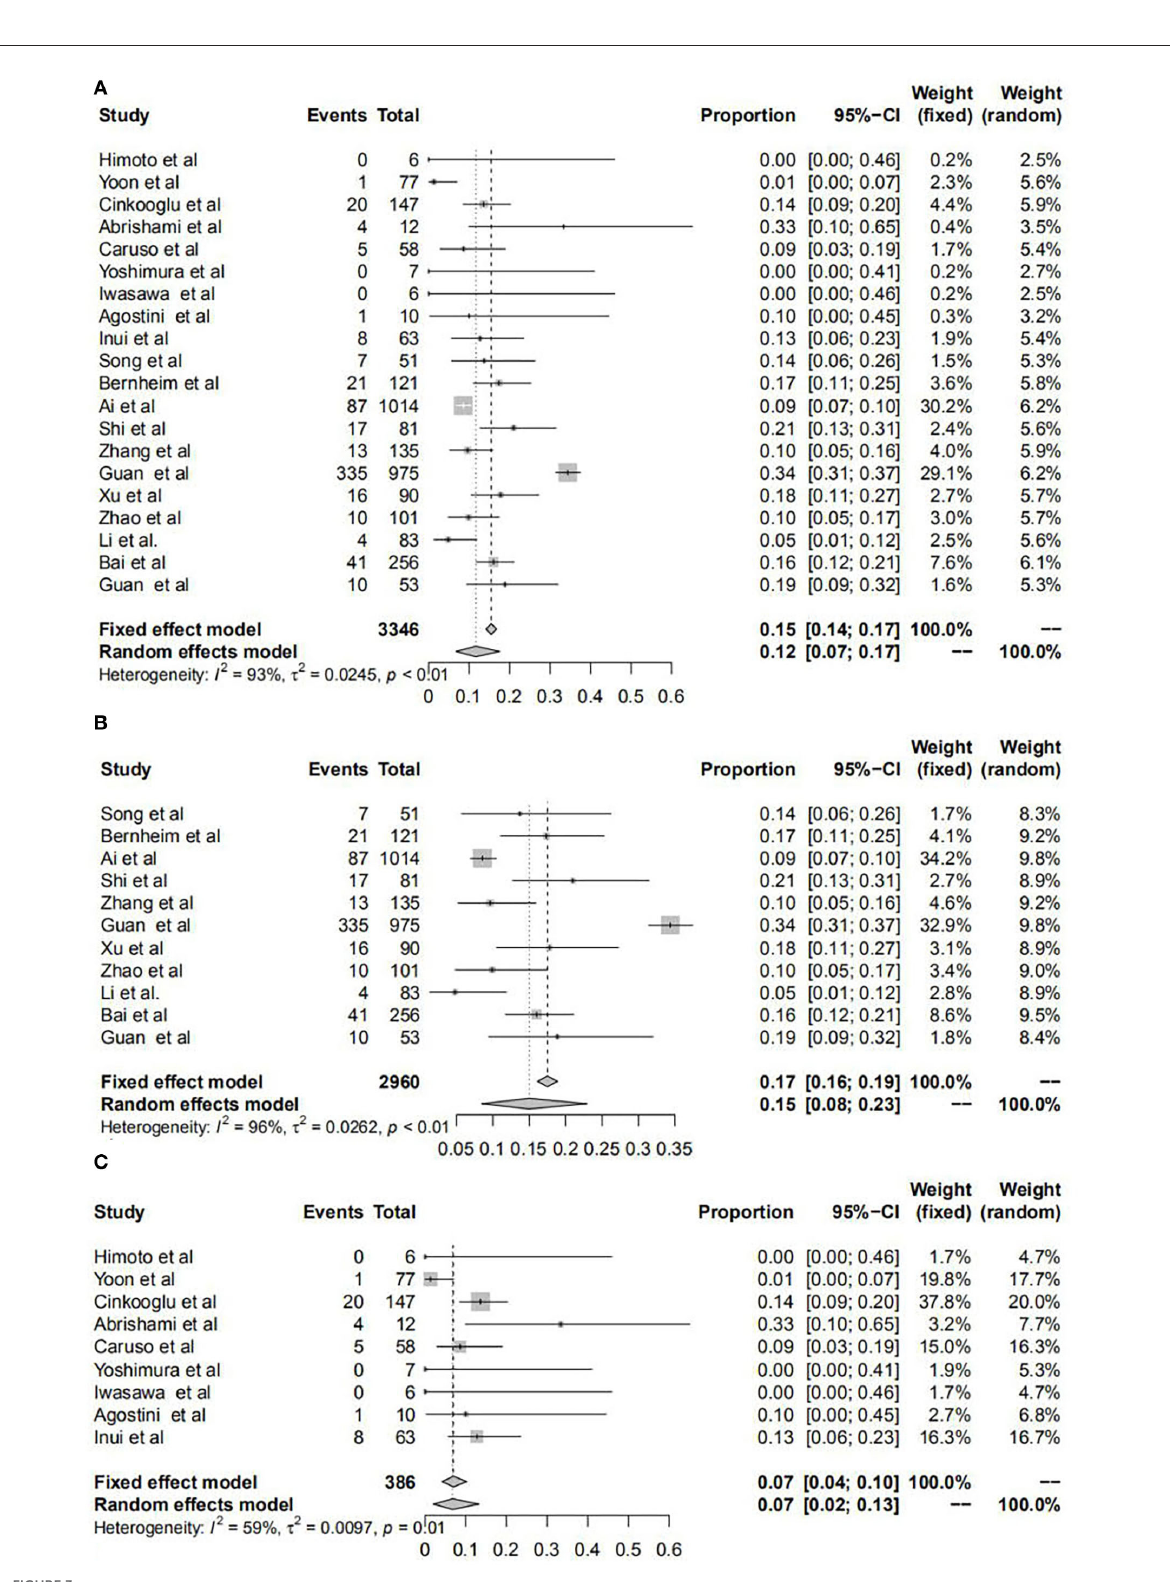
FIGURE3 Forest plots of unilateral lung infection manifested by chest CT for patients with COVID-19. Forest plots show the transformed incidence rate of unilateral lung involvement in all patients (A) , patients within mainland China (B) , and patients outside mainland China (C) . COVID-19: coronavirus disease 2019; CI, confidence